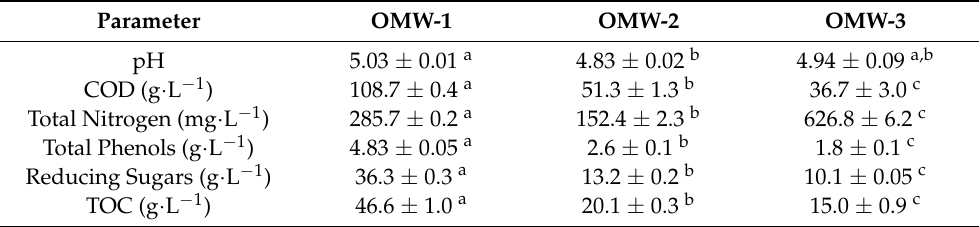
Table 1. Main characteristics of olive mill wastewater (OMW). Data are the average ± standard deviation of two independent measurements. Values followed by the same letter in each row do not present statistically significant differences ( p ≤